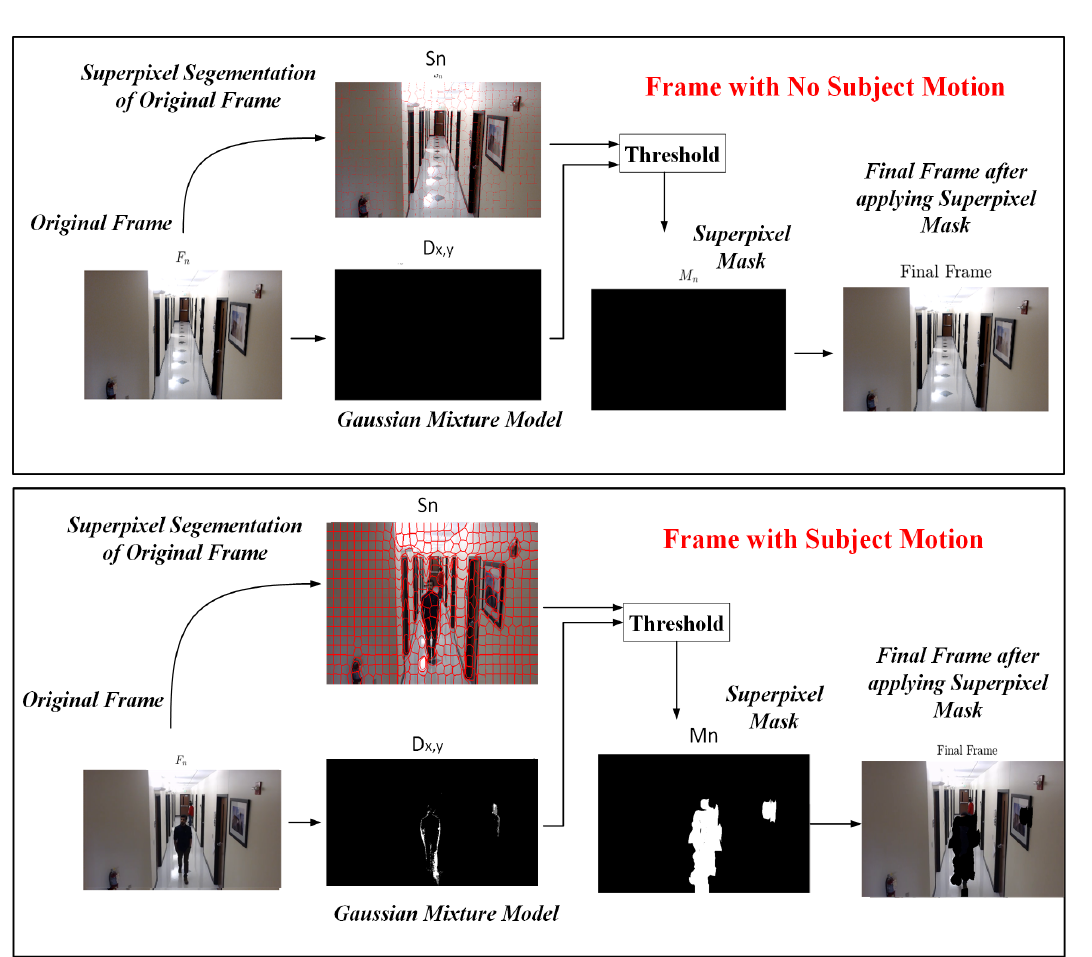
Figure 6. Algorithm flow of the Selective Superpixel Segmentation Masking.